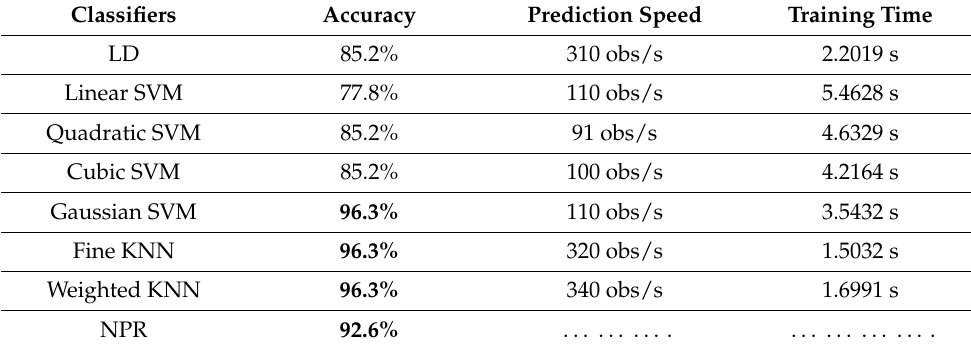
Table 5. Classification outcome information (women